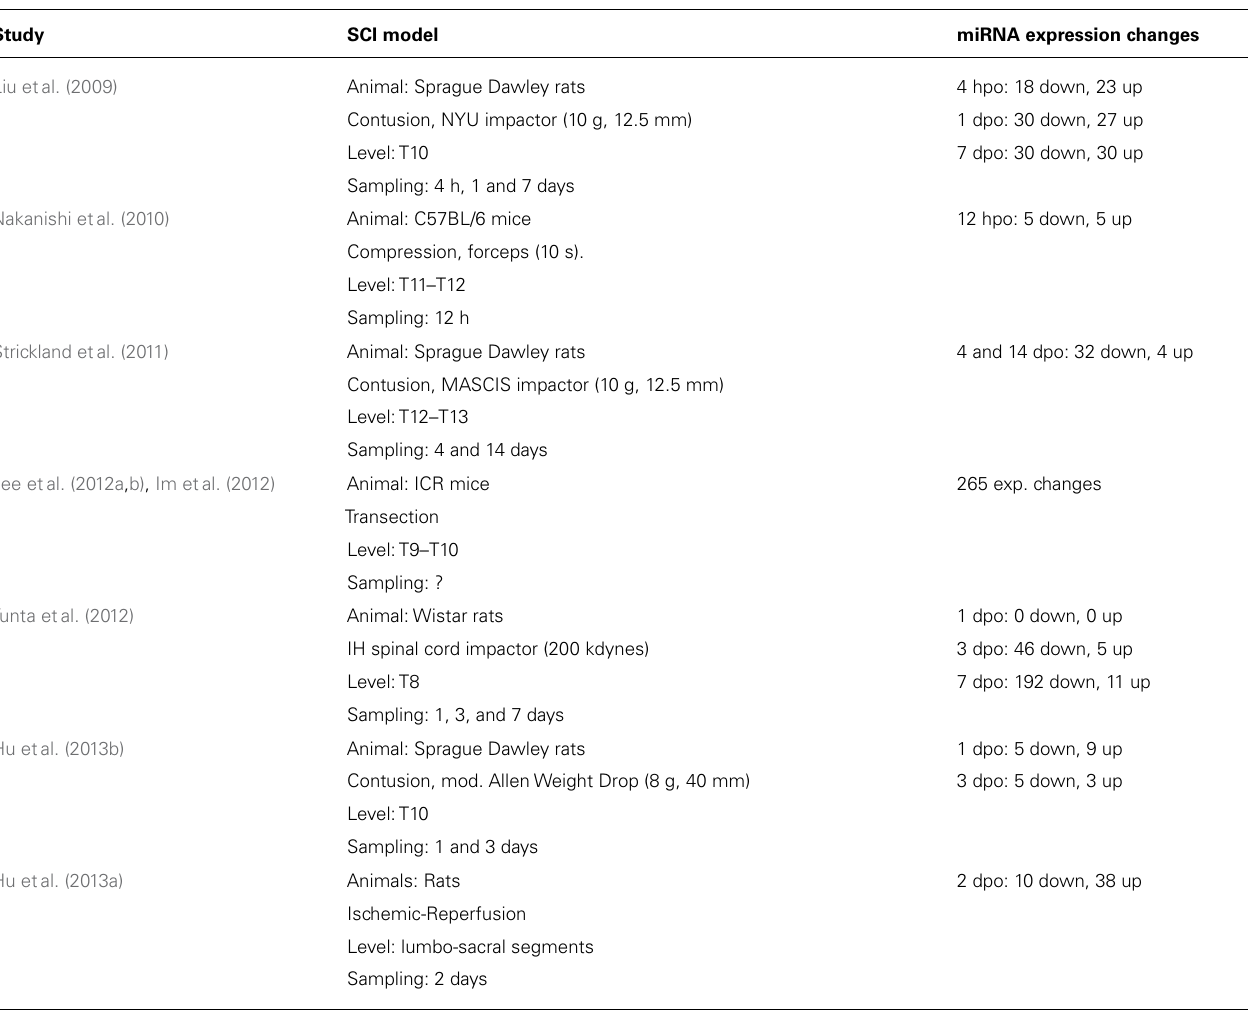
Table 1 | Global analyses of microRNA expression after